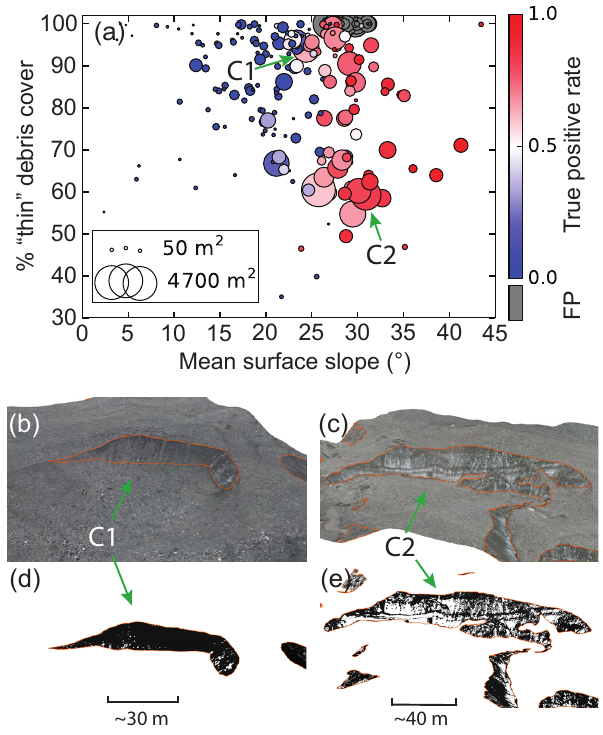
Figure 7. (a) Each “true” manually mapped ice cliff on Canwell Glacier is shown as a circle sized proportionally to map-view sur- face area and plotted against the mean ice cliff surface slope and the percentage of “thin” debris cover on the ice cliff face. The color scale shows the true positive rate from the automated ice cliff map- ping method derived for each ice cliff. FP ice cliffs, defined as iso- lated shapes that are solely FP area and do not share a boundary with a “true” ice cliff, are colored grey and abbreviated as FP on the axis label. Two ice cliffs (C1 and C2) are shown to illustrate how “thin” debris cover was mapped and provide context to the data presented in panel (a) . Panels (b) and (c) are oblique views of the 29 July 2016 Canwell Glacier orthomosaic with manually gen- erated ice cliff outlines shown in orange. Panels (d) and (e) are the same views with the orthomosaic processed to identify only debris cover on ice cliff faces. C1 is nearly 100% debris-covered which could draw its classification as an ice cliff into question. C2 is one of the more “clean” ice cliffs within the Canwell Glacier study area but is still covered by a non-trivial amount, > 50%, of debris. C1 shows linear englacial debris bands that contribute to the ice cliff face debris accumulation. Location shown in Fig. 2.